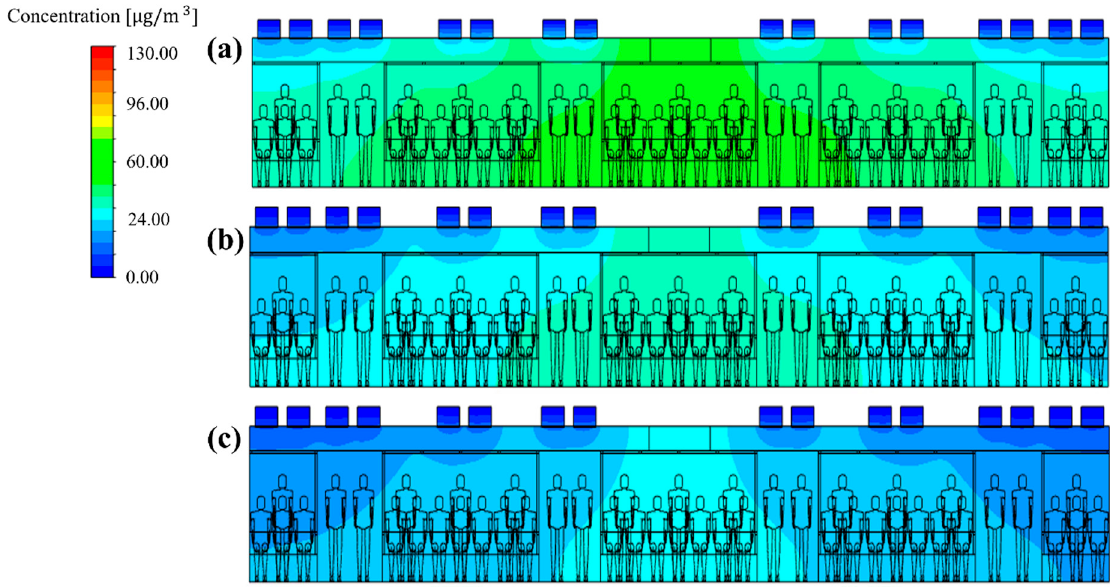
Figure 15. PM 10 concentration distribution in the subway cabin according to the total ventilation flow rate (filter efficiency of 85% and flow rate ratio of 20:20:60 applied). ( a ) 500 CMH (case 3); ( b ) 600 CMH (case 31); and ( c ) 700 CMH (case 32).